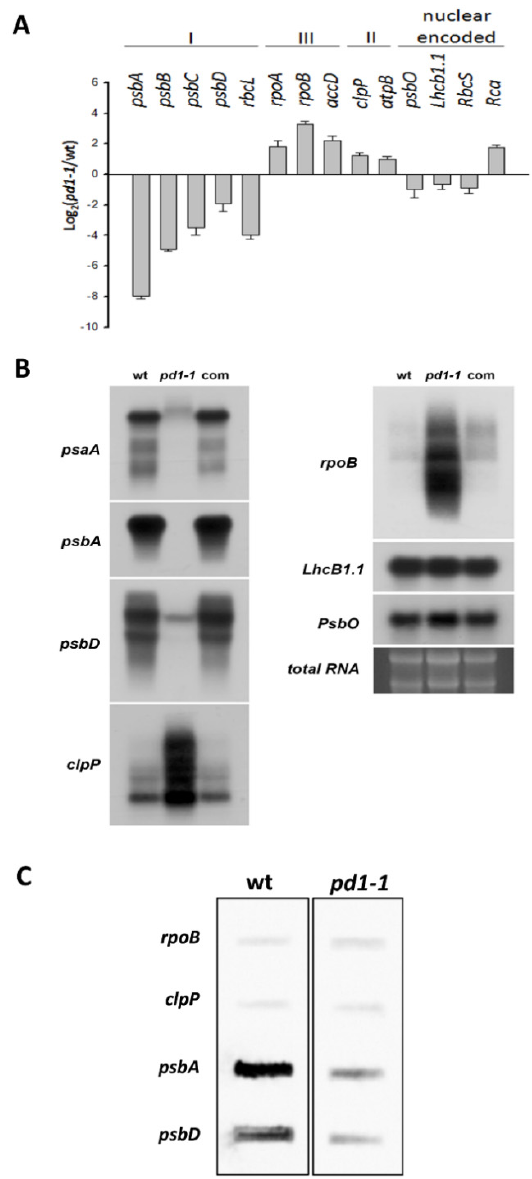
Figure 7. Transcriptional analysis of the chloroplast genes in wild type, pd1-1, and complemented seedlings. ( A ) Analysis of the chloroplast gene transcripts by RT-quantitative real-time PCR. The log 2 ( pd1-1 /wt, pd1-1 mutant/wild type) values were calculated and normalized by using actin as a reference. I. PEP-dependent chloroplast genes; II. NEP-dependent chloroplast genes; III. Both PEP- and NEP-dependent chloroplast genes. The values shown are the average of three independent replicates. Error bars indicate SD. ( B ) Analysis of chloroplast gene transcripts by northern blot. The RNA on the agarose gel stained with ethidium bromide is shown as a loading control . 10 μ g total RNA per lane. ( C ) Analysis of the transcriptional rate of the chloroplast genes in wild type and pd1-1 plants via run-on assay. The filters were probed with run-on transcripts derived from chloroplasts isolated from wild type and pd1-1 seedlings. The experiments were repeated three times independently, and the data from one representative experiment are presented.